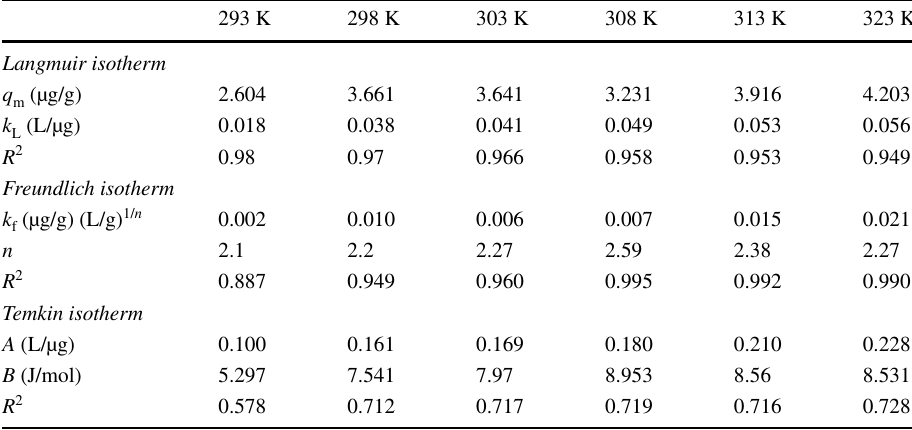
Table 1 Isothermal parameters for arsenic adsorption on modified Saxaul ash at different